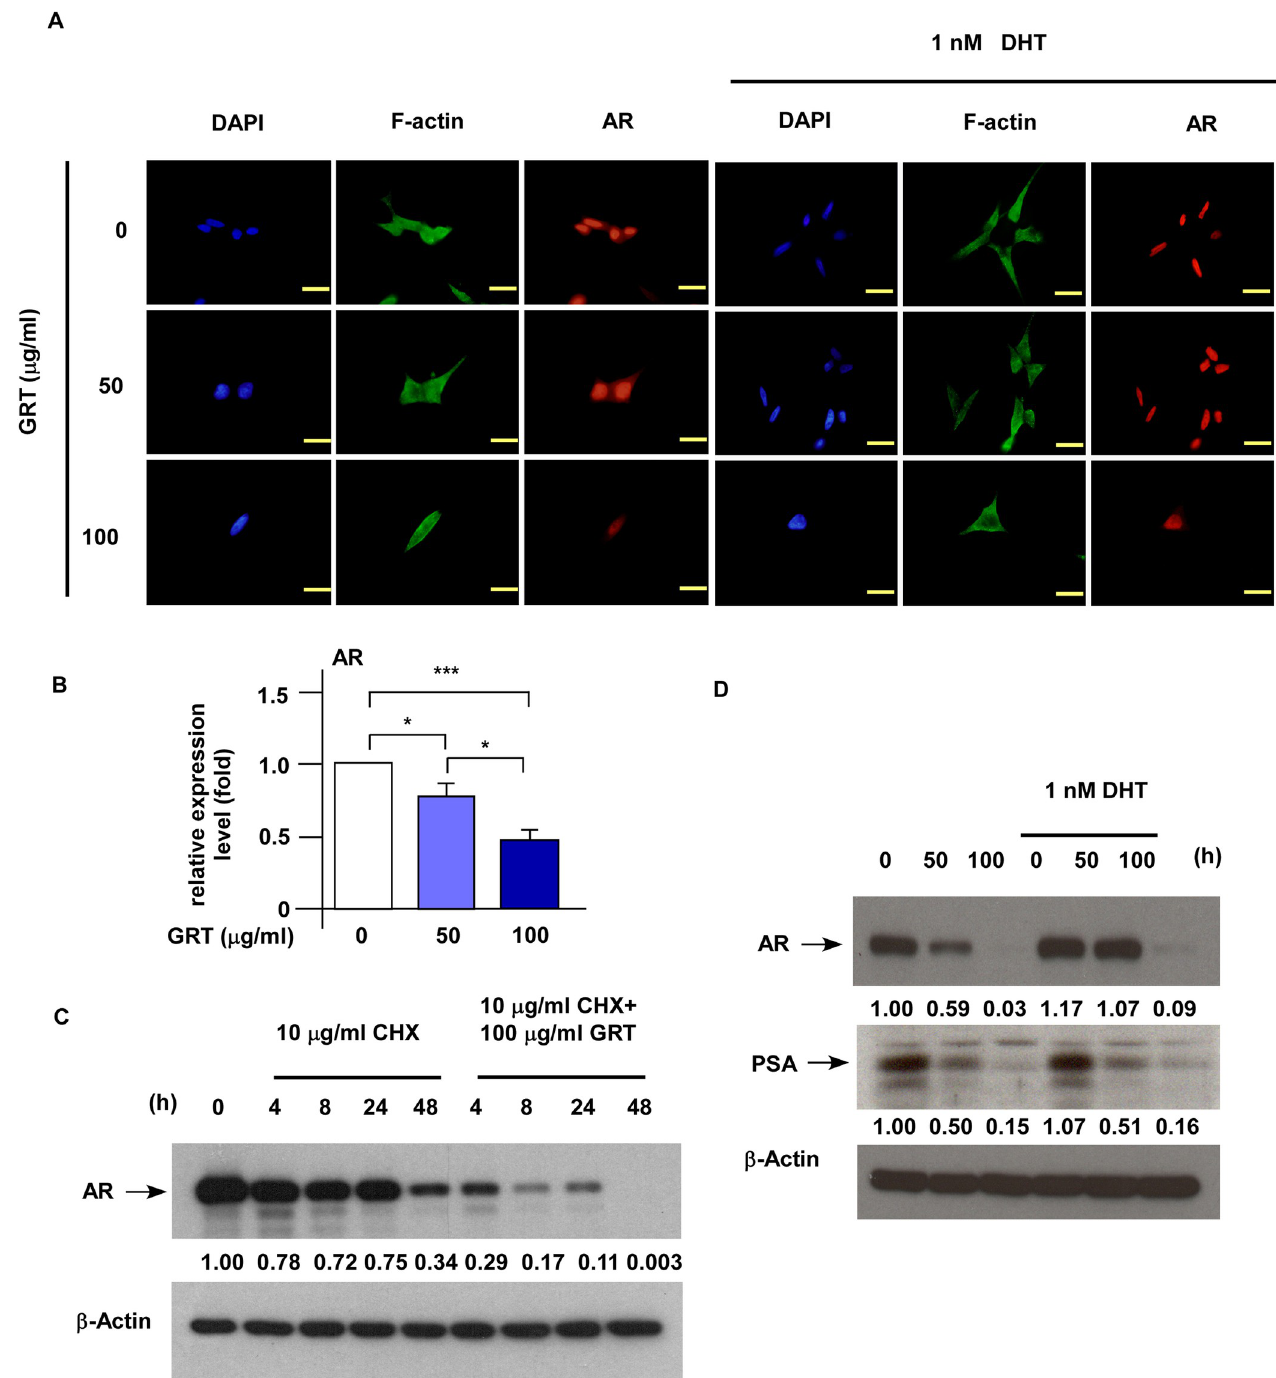
Fig 7. GRT treatment suppresses the protein expression, stability, and downstream signaling of AR in C4-2 MDV3100r cells. (A) C4-2 MDV3100r cells being treated with or without 1 nM DHT or increasing concentration of GRT (0, 50, 100 μ g/ml) for 48 h was observed by immunofluorescent microscopy. The column from left to right shows DAPI (blue), F-actin (green), and AR (androgen receptor) (red) images. The magnification of the microscope is 100X and the yellow scale bar represented 100 μ m. (B) Expression of AR mRNA in C4-2 MDV3100r cells being treated with 0, 50, 100 μ g/ml was examined by qRT-PCR. Asterisk � and ��� represents statistically significant difference p < 0.05 and p < 0.001, respectively, between the two groups of cells being compared. (C) C4-2 MDV3100r cells were treated with 10 μ g/ml cycloheximide with or without 100 μ g/ml GRT for 0, 4, 8, 24, 48 h. Expression of AR protein was examined by Western blotting and the β -actin was used as loading control. (D) LNCaP C4-2 MDV3100r cells were treated with or without 1 nM DHT along with increasing concentration of GRT (0, 50, 100 μ g/ml) for 96 h. Abundance of AR and PSA protein was determined by Western blotting. The β -actin was used as loading